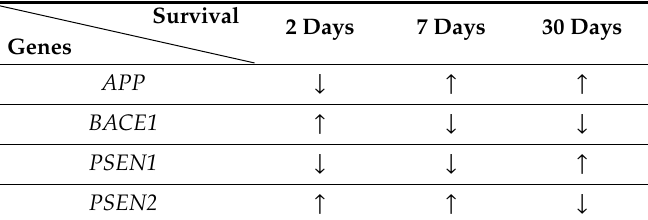
Table 3. Changes in the expression of Alzheimer’s disease-associated genes in the medial temporal cortex at di ff erent times after experimental brain ischemia [64,65]. Survival 2 Days 7 Days 30 Days Genes APP ↓ ↑ ↑ BACE1 ↑ ↓ ↓ PSEN1 ↓ ↓ ↑ PSEN2 ↑ ↑